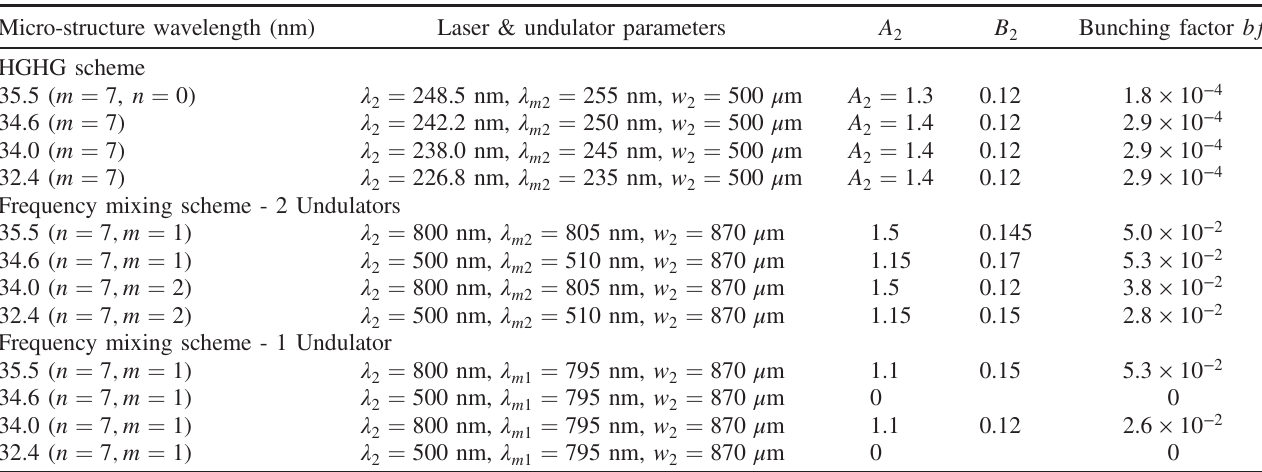
TABLE I. Bunching factor at 35.5 nm, 34.6 nm, 34 nm, and 32.4 nm obtained with the HGHG scheme and with the frequency mixing scheme (with 1 or 2 undulators), using a moderate laser source ( 10 μ J at λ 2 and 130 μ J at λ 1 ¼ 260 nm). The energy modulation amplitude is obtained from numerical simulations (cf. Sec. II) with the same parameters as in Fig. 3 unless otherwise mentioned (the values of λ m 2 has to be optimized to obtain the maximum value of A 2 ). A 1 ¼ 5 for the frequency mixing scheme and A 1 ¼ 0 for the HGHG scheme. For each case, B 2 is optimized to get the maximum bunching factor. Micro-structure wavelength